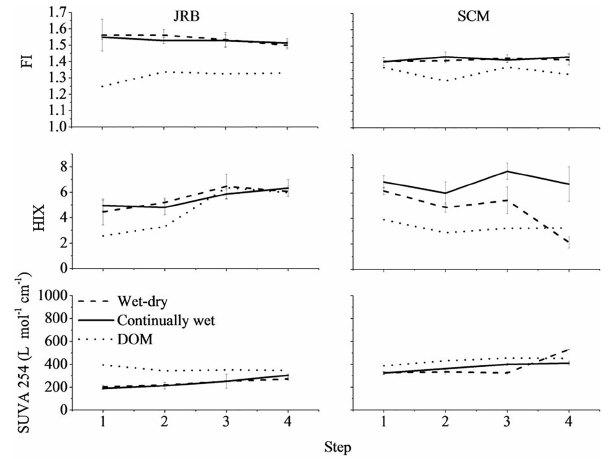
Figure 2. The fluorescence Index (FI), humification index (HIX) and specific UV absorbance at 245nm (SUVA 254 ), for equilibrated solutions reacted with JRB and SCM soils. The solid lines are wet– dry series, dashed lines are continuously wet and dotted lines are unreacted DOM; error bars are the standard